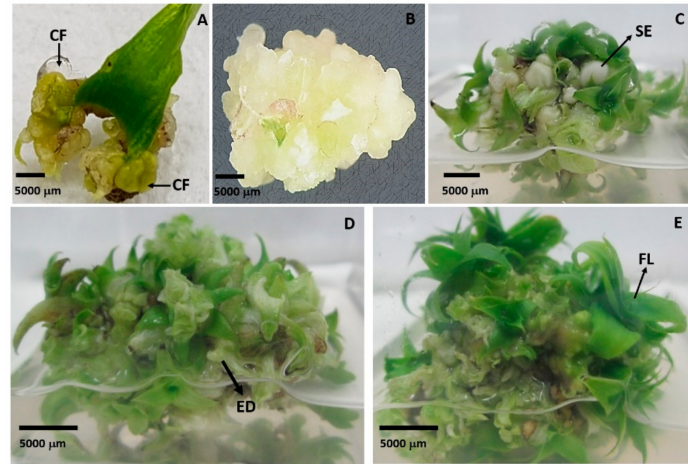
Figure 3. Indirect somatic embryogenesis (ISE) from young leaves of ‘MD2’ pineapple grown in the M7 treatment (2 mg L − 1 of 2,4-D and 2 mg L − 1 of BAP). ( A ) Incipient callus formed at the base of the leaf, CF: callus formation; ( B ) primary callus of vitreous white color, semicompact consistency; ( C ) embryogenic callus of greenish white color, with embryogenic structures (SE) visible at various stages of development; ( D ) appearance of globular embryos; ED: advance stage of embryo development; ( E ) high embryogenic capacity of the induced callus, with embryos multiplying and developing asynchronously; FL: foliar primordia.